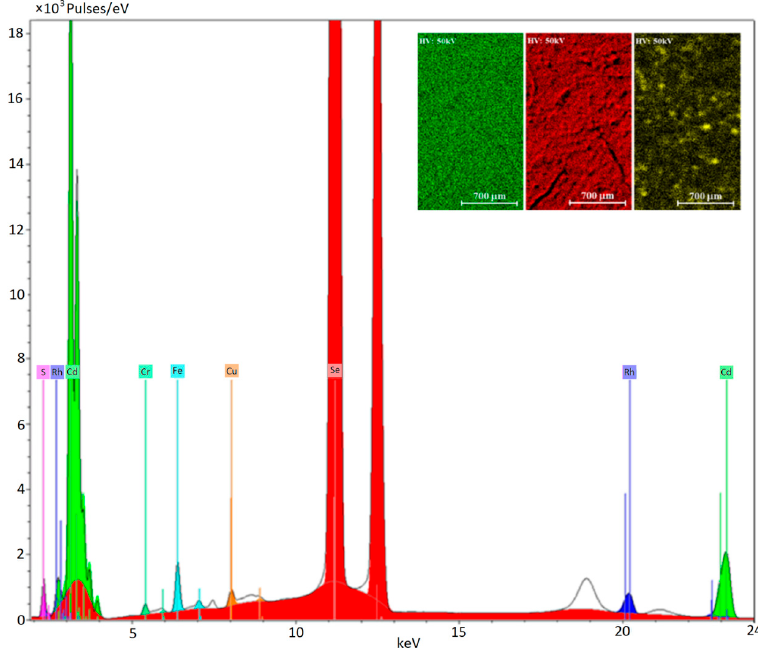
Figure 8. Bottom : XRF spectrum of the reaction product of CdSe NPs with H 3 L. X-axis: energy (keV), Y-axis: intensity. Top : XRF mapping of the reaction product between CdSe NPs and H 3 L with elemental distribution of sulfur (yellow), selenium (red), and cadmium (green) on the sample surface.